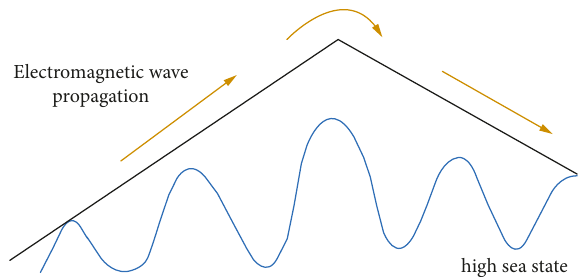
Figure 3: Equivalent single-edge diffraction model for electro- magnetic wave propagation in high sea state.